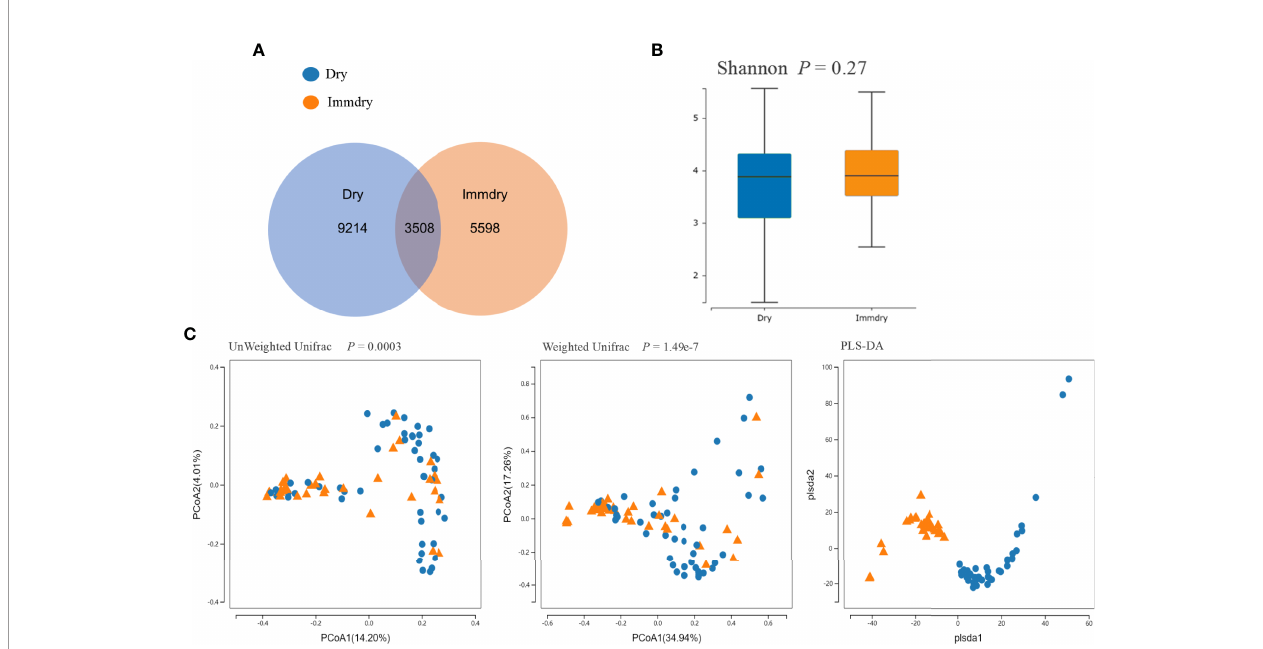
FIGURE 1 | Comparisons of the alpha diversity and beta diversity between dry eye and immdry eye patients. (A) Venn diagram showing overlaps of the operational taxonomic units (OTUs) between the two groups. (B) Alpha diversity of the dry eye microbiome similar to that of immdry eye, as quanti fi ed by diversity indices (Shannon, p = 0.27). (C) Principal coordinate analysis (PCoA) of bacterial beta diversity based on the unweighted ( p = 0.0003) and weighted ( p = 1.49e − 7) UniFrac distances and partial least squares – discriminant analysis (PLS-DA) dissimilarity. Dry eye and immdry eye subjects are indicated in blue and orange ,